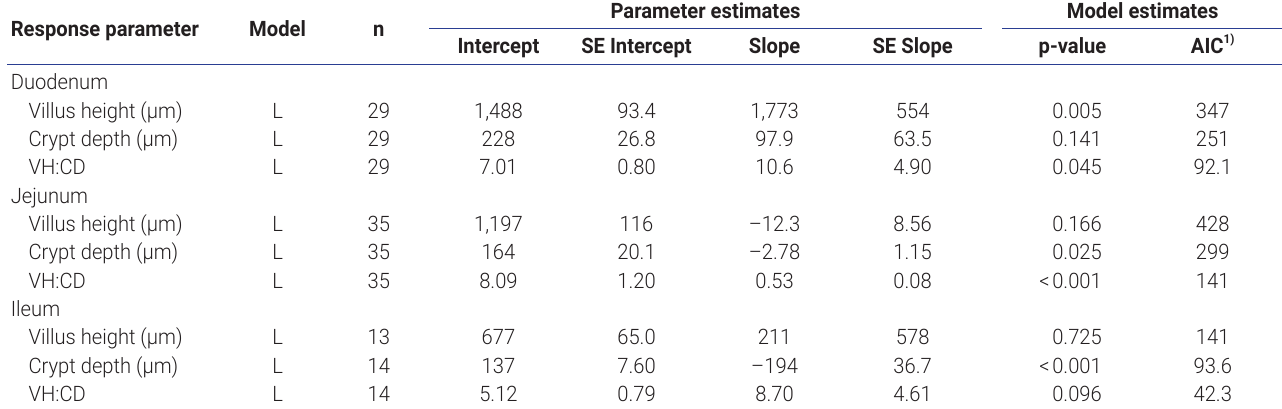
Table 5. Regression equations on the influence of flavonoid-rich herbs (in % of diet as fed) on small intestinal morphology of